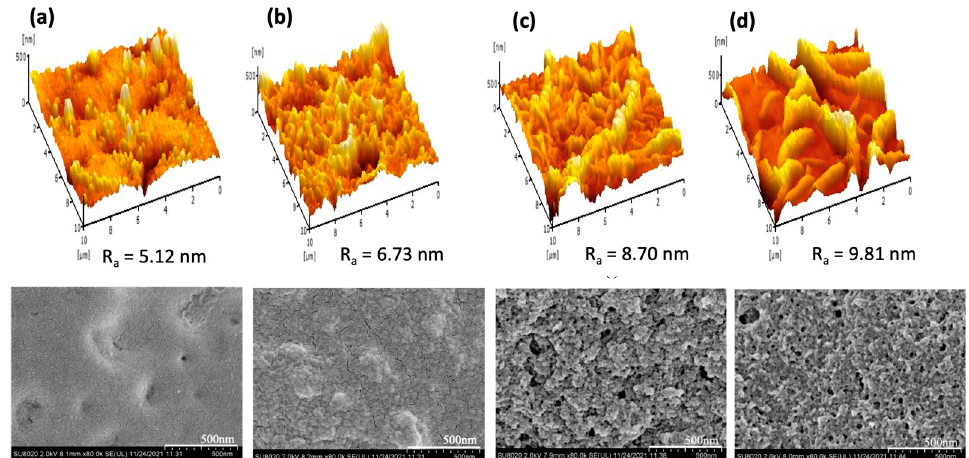
Figure 7. Three-dimensional AFM images ( top ) and FESEM images ( bottom ) of bottom surface of substrates with and without coating: ( a ) TFC NF (control), ( b ) PDA/GO0.3, ( c ) PDA/GO0.5, and ( d ) PDA/GO0.7.